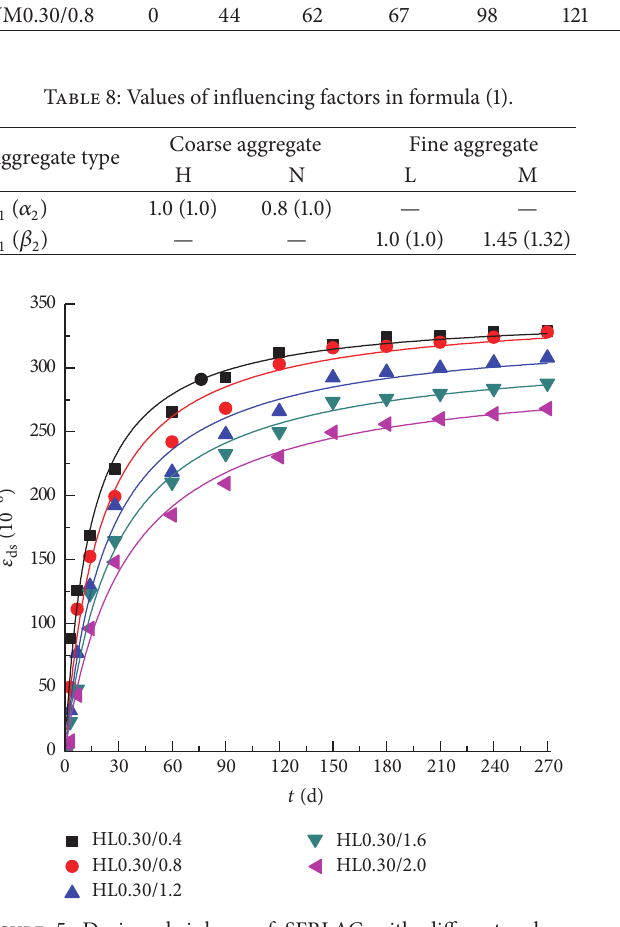
Figure 5: Drying shrinkage of SFRLAC with different volume fraction of steel